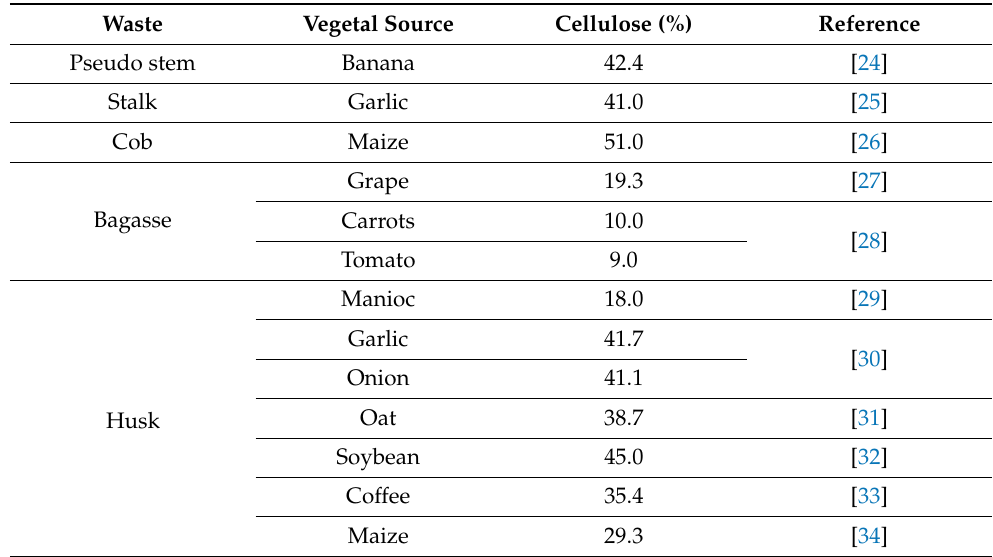
Table 1. Percentages of cellulose composition in plant